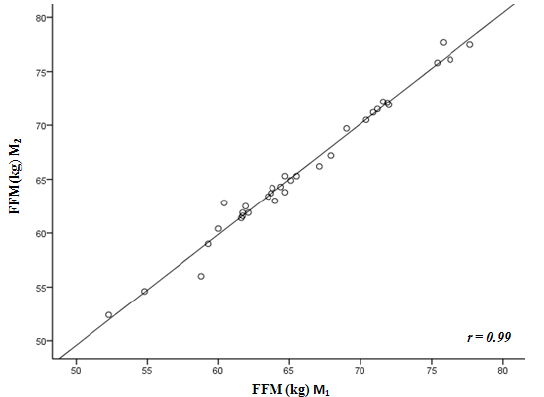
Figure 5. Correlation between the values of param- eters measured by Tanita before and after the intake of fluids – fat free mass